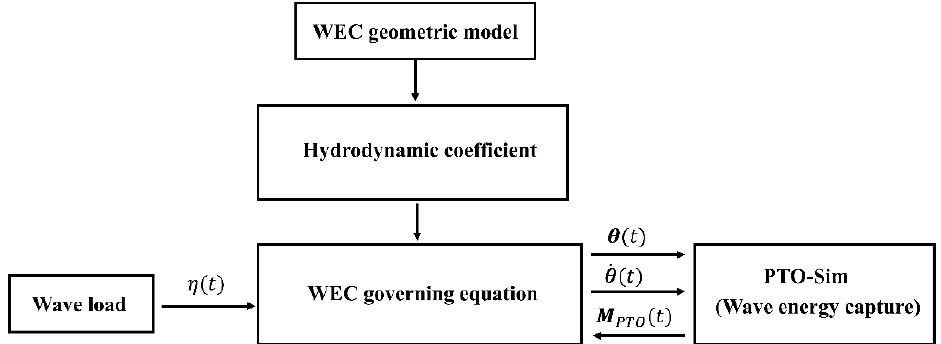
Figure 2. Workflow